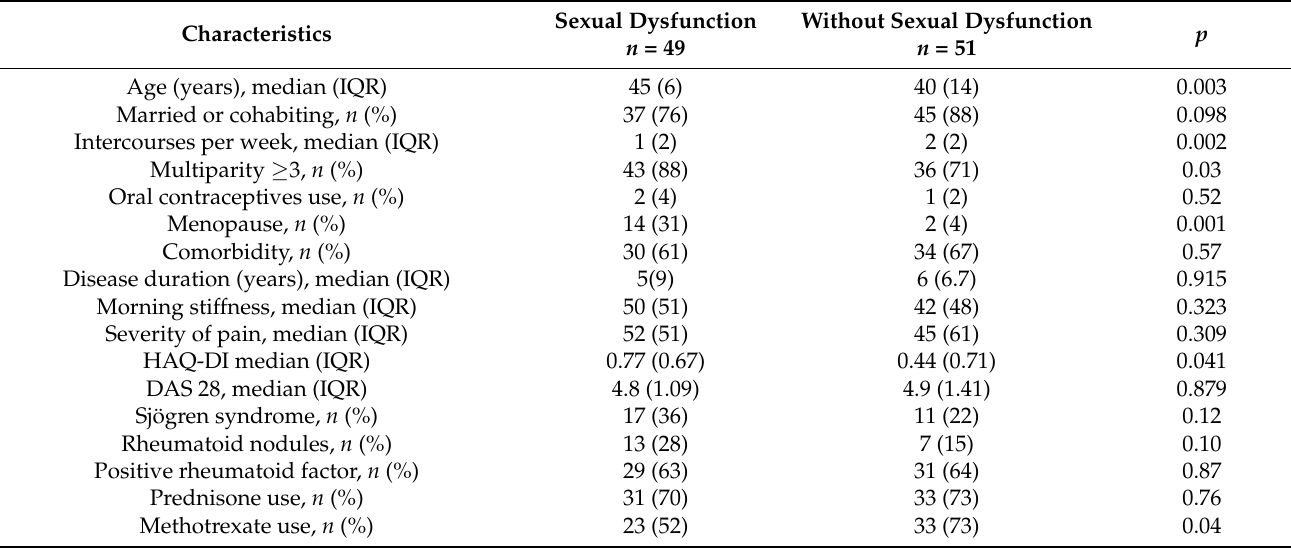
Table 3. Characteristics associated with sexual dysfunction in patients with rheumatoid